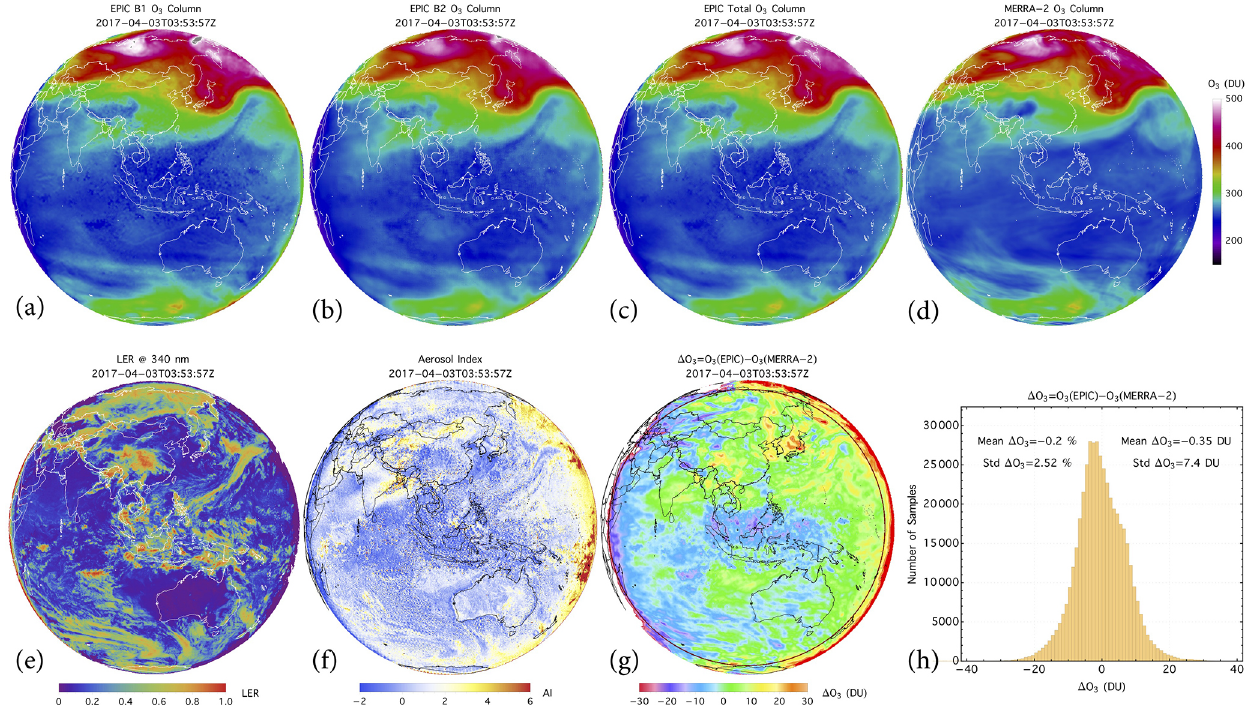
Figure 15. An L2 O3SO2AI granule contains the total O 3 vertical columns (c) , LER at 340nm (e) , and AI (f) retrieved from EPIC UV measurements at 03:53:57UTC on 3 April 2017. (a) Total O 3 column (referred to as B1 total O 3 column) retrieved from EPIC B1, B3, and B4. (b) Total O 3 column (referred to as B2 total O 3 column) retrieved from EPIC B2, B3, and B4. (c) Total O 3 from all four bands. (d) Coincident MERRA-2 total O 3 columns. (g) The total O 3 difference: O 3 ( EPIC ) − O 3 (MERRA-2). (h) The histogram of the O 3 differences with SZA ≤ 70 ◦ , i.e., samples within the circle in (g) , with a mean difference µ( EPIC ) = − 0 . 20% (or − 0 . 35DU) and a standard deviation σ( EPIC ) = 2 . 52% (or 7.4DU). Similarly, the O 3 difference, O 3 ( EPIC B1 ) − O 3 (MERRA-2), has a mean of µ( EPIC B1 ) = 0 . 25% (or 1.03DU) and a standard deviation σ( EPIC B1 ) = 2 . 68% (or 7.9DU), and O 3 ( EPIC B2 ) − O 3 (MERRA-2) has a mean µ( EPIC B2 ) = − 0 . 41% (or − 1 . 08DU) and a standard deviation σ( EPIC B2 ) = 2 . 68% (or